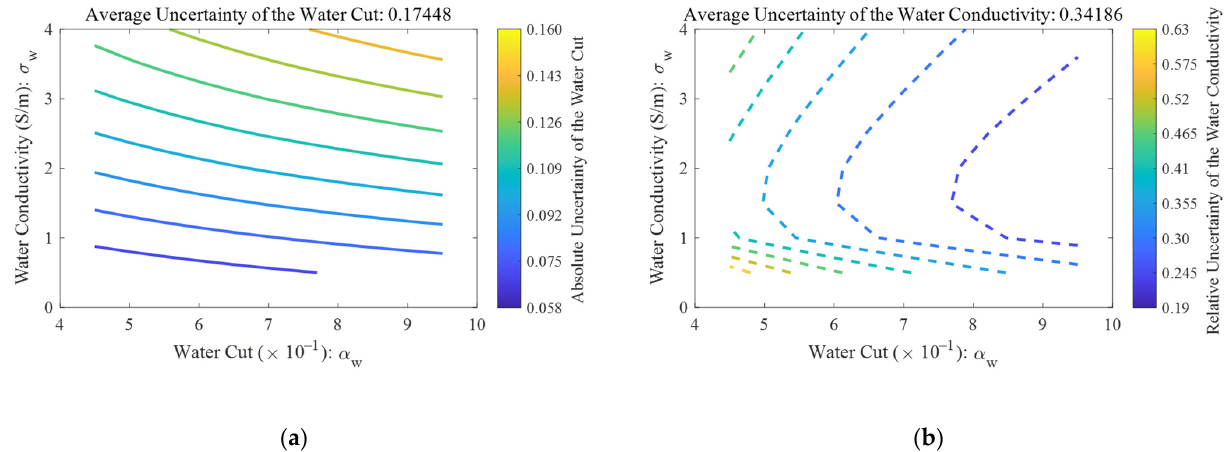
Figure 11. The measurement uncertainty distributions of the microwave network analyzer under water-continuous flow conditions: ( a ) the absolute uncertainty of water cut; ( b ) the relative uncertainty of water conductivity.